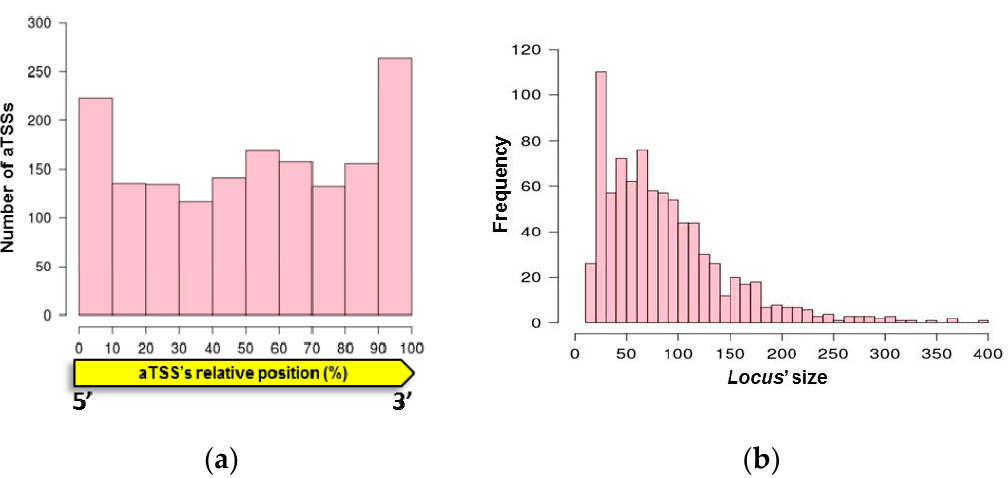
Figure 1. Antisense RNA (asRNA) properties. ( a ) Antisense transcription start site (aTSS) positions relative to cognate genes. ( b ) Size distribution of mapped asRNAs.